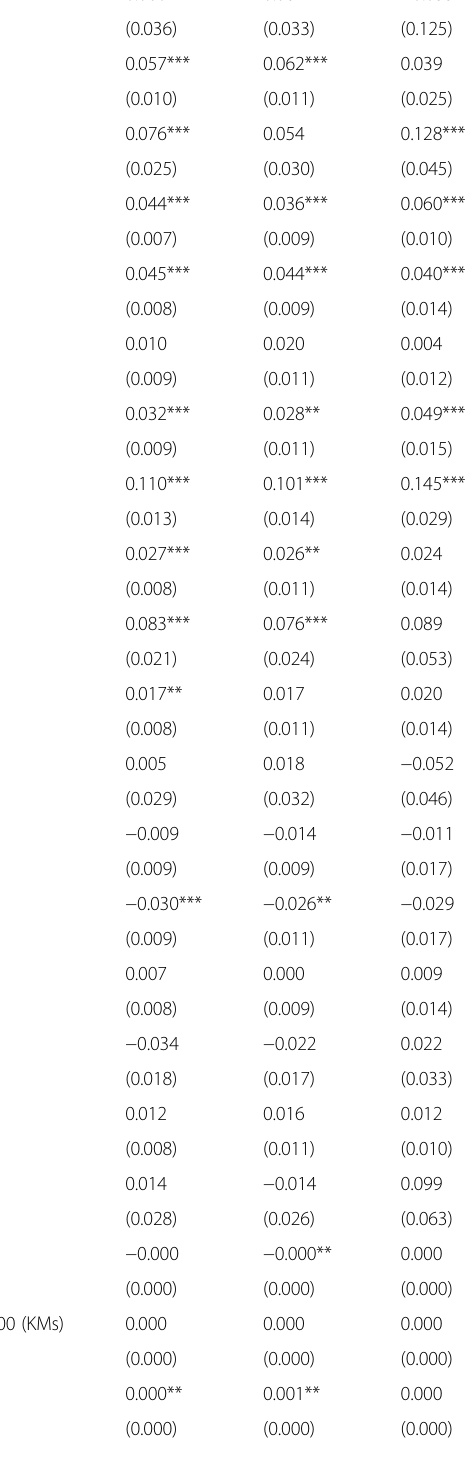
Table 3 The link between consumption of food group and household MPA